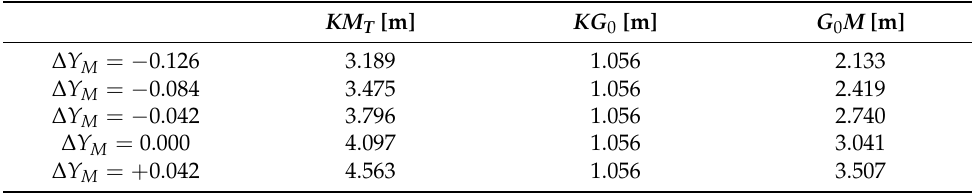
Table 3. The metacentric height of initial and varied hull